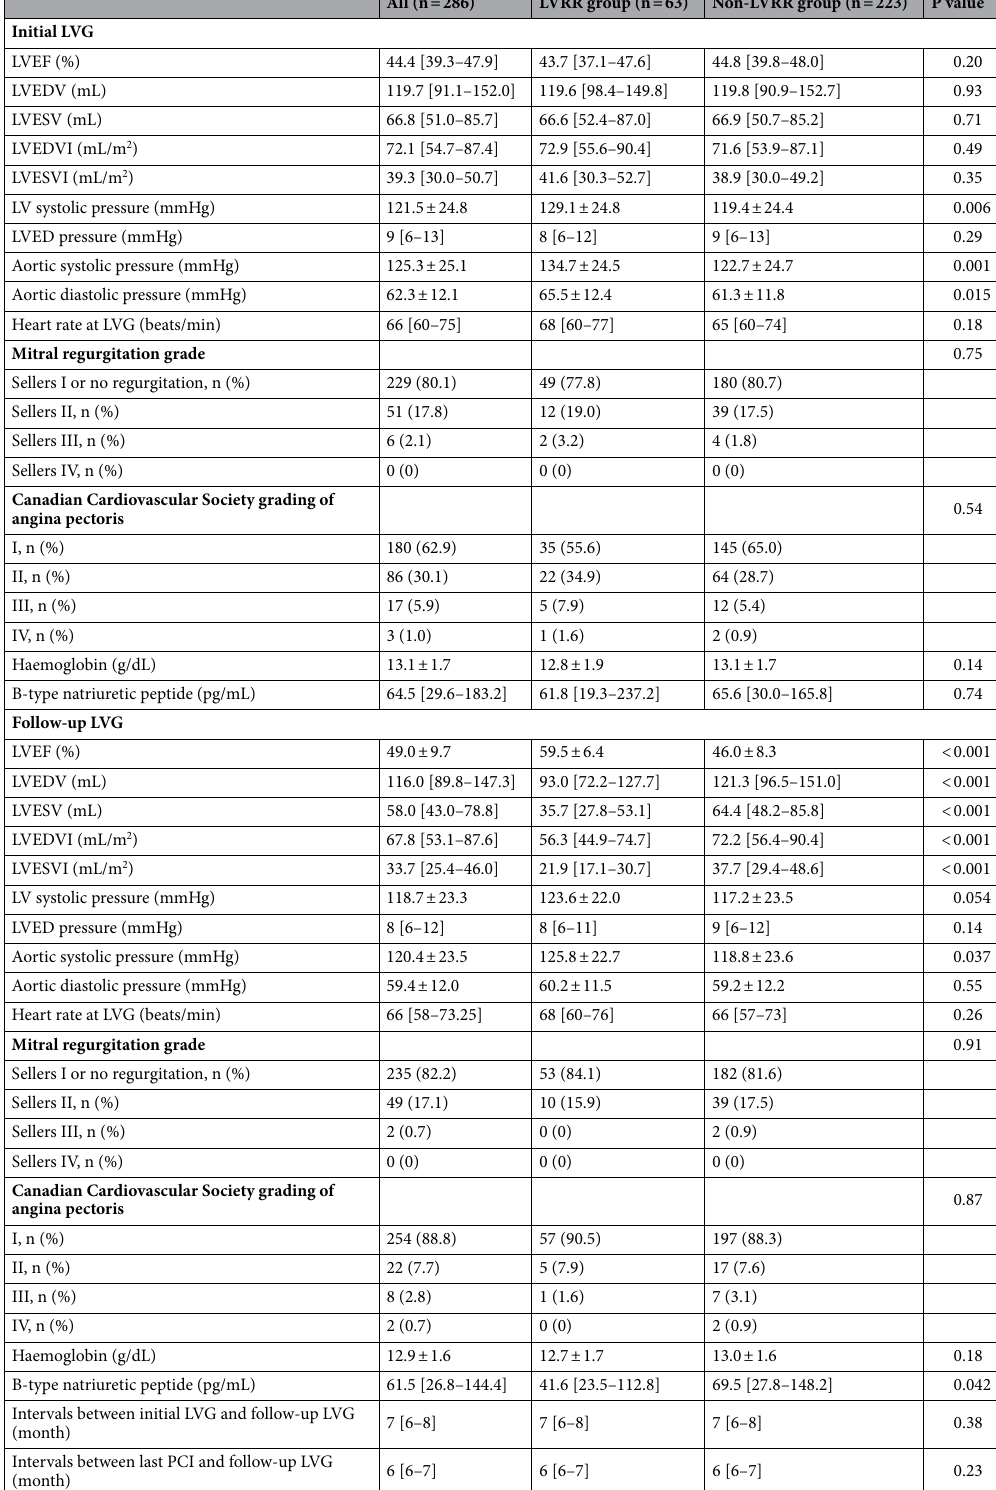
Table 2. Left ventriculography (LVG) findings. Data are expressed as numbers (%), mean ± standard deviation, or median [interquartile range]. LVEF left ventricular ejection fraction; LVEDV left ventricular end- diastolic volume; LVESV left ventricular end-systolic volume; LVEDVI left ventricular end-diastolic volume index; LVESVI left ventricular end-systolic volume